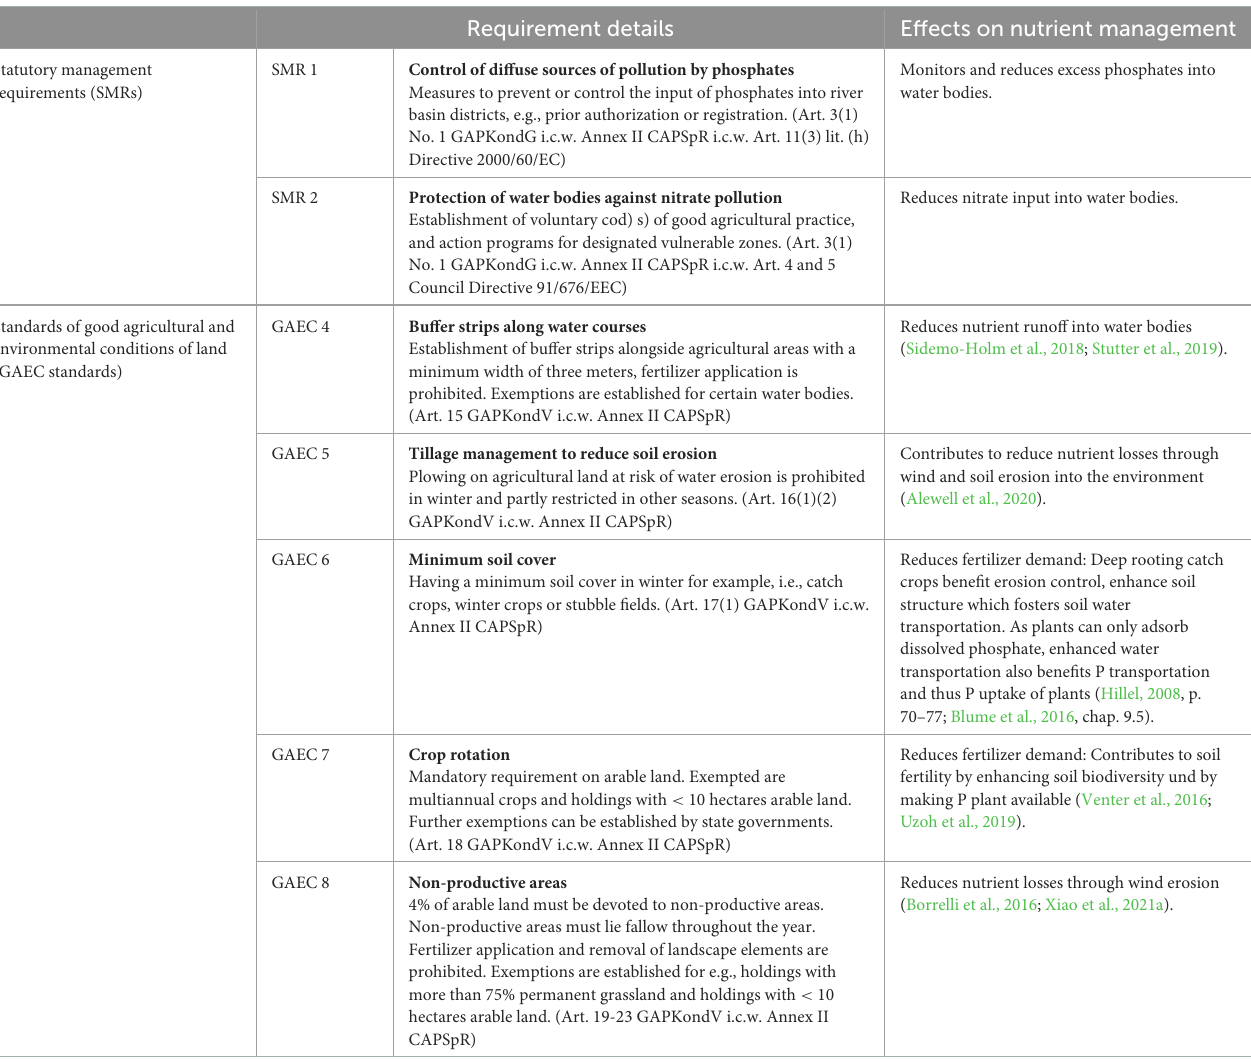
TABLE 2 Nutrient relevant requirements of